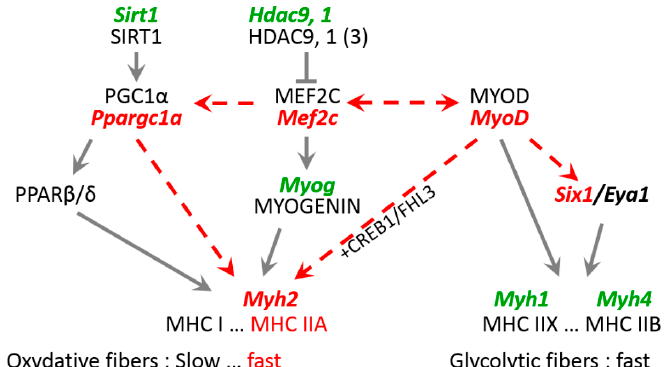
Figure 5. Expression pathways for genes encoding key factors related to Myh2 and MHC IIA expression that are induced by expression of mutant lamin A in mouse TA. Bold, italic, green text indicates no change in mRNA expression; bold, italic, red text indicates reduced mRNA expression. Dashed lines indicate hypothetical altered pathways that decrease levels of Myh2 mRNA and MHC